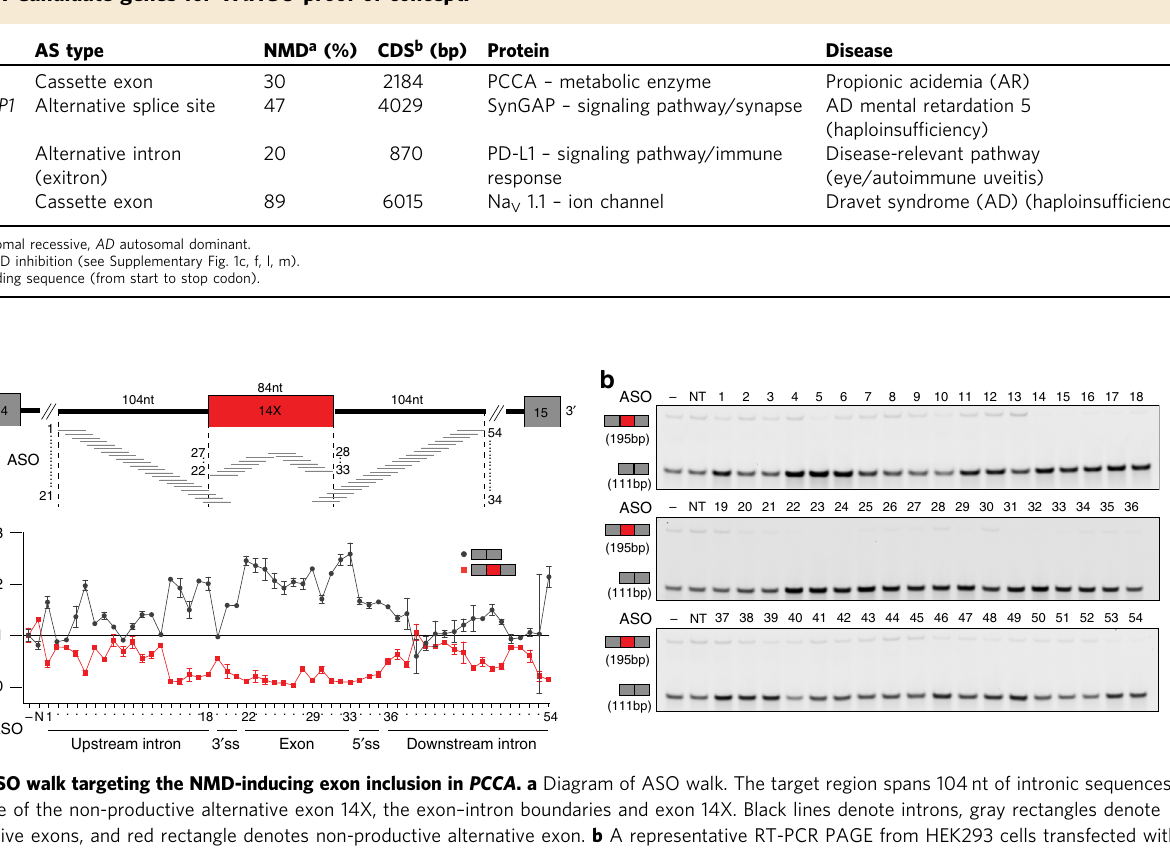
Table 1 Candidate genes for TANGO proof of concept.